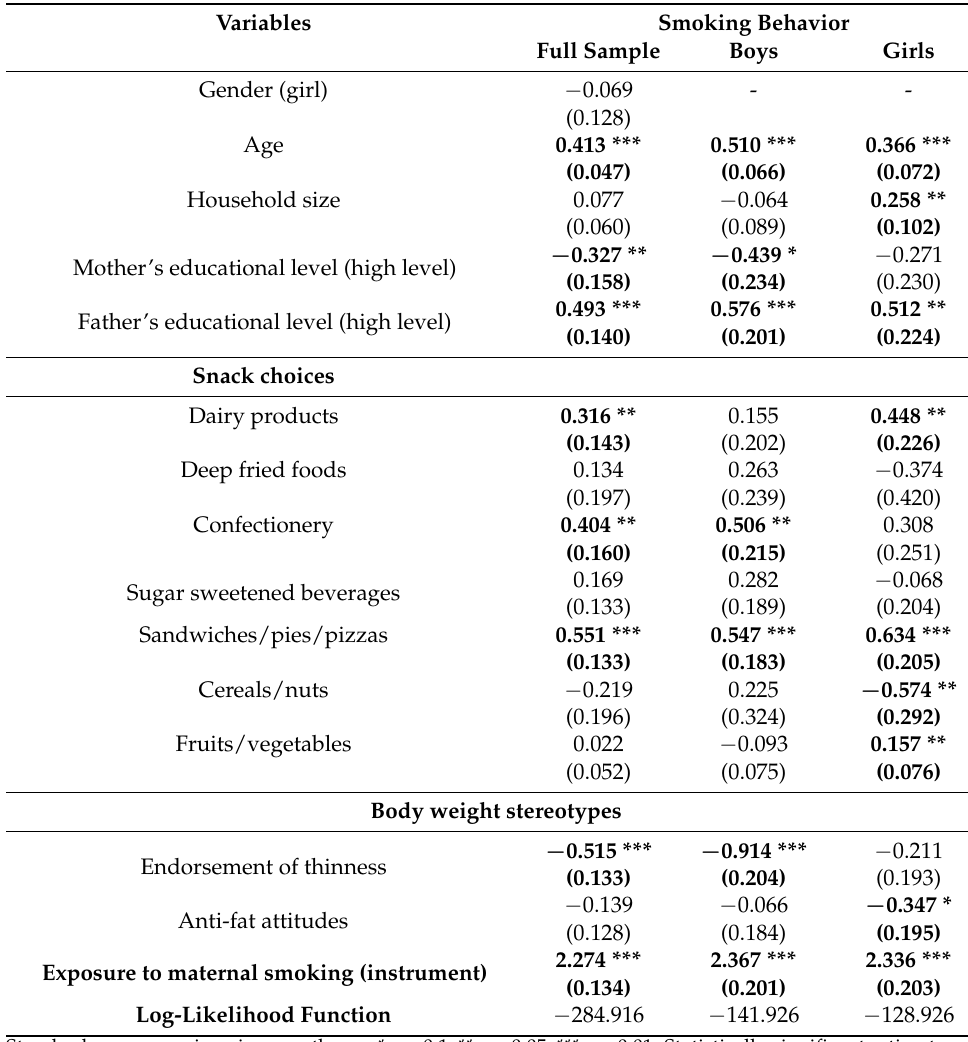
Table 4. Adolescents’ smoking estimates—Treatment equation of the endogenous treatment ef- fects